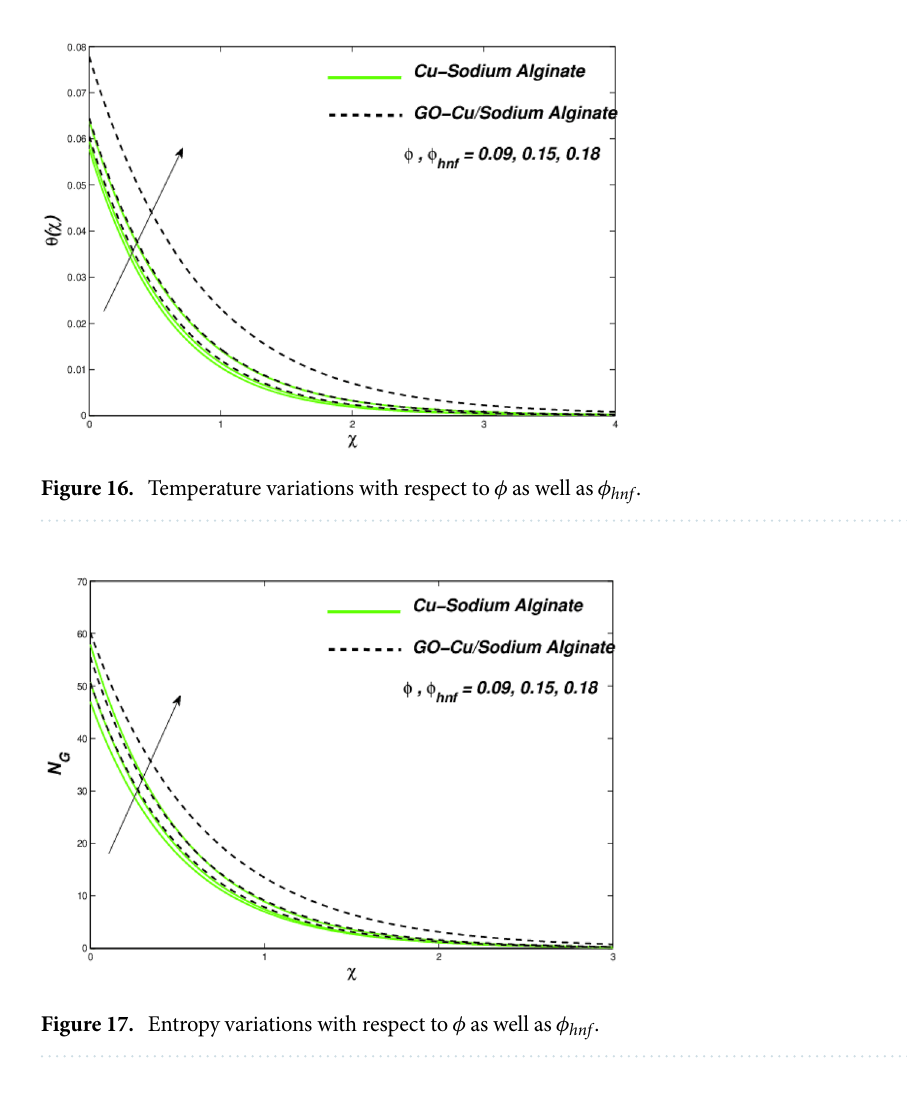
Figure 15. Velocity variation versus φ as well as φ hnf .